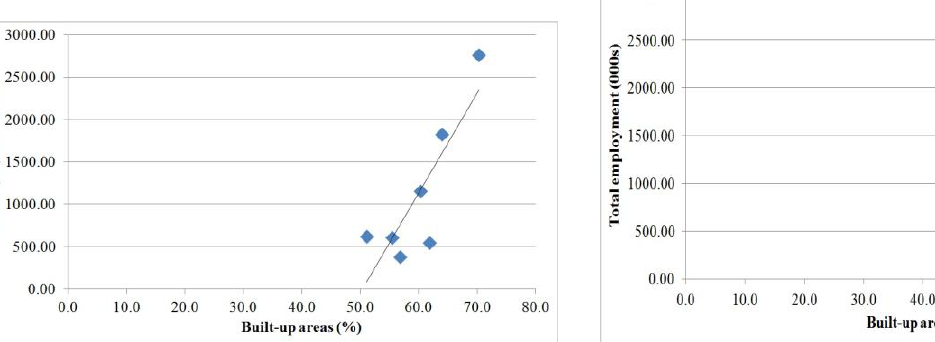
Figure 12. Relationship between the Percentage of Built-up areas and GDP for 2005 ( R 2 = 0.72)